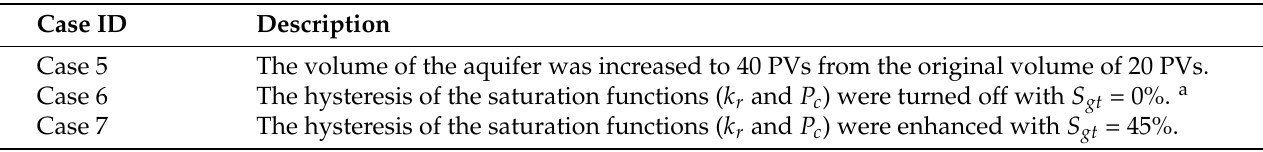
Table 2. Descriptions of the simulation cases for studying the influence of the aquifer water encroachments (cases 5 to 7). Case ID